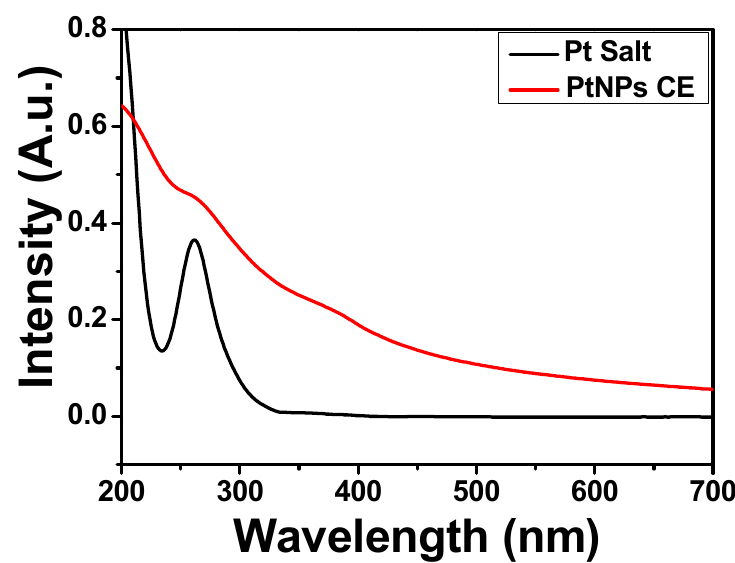
Figure 1. Absorbance spectra of platinum salt and PtNPs CE.